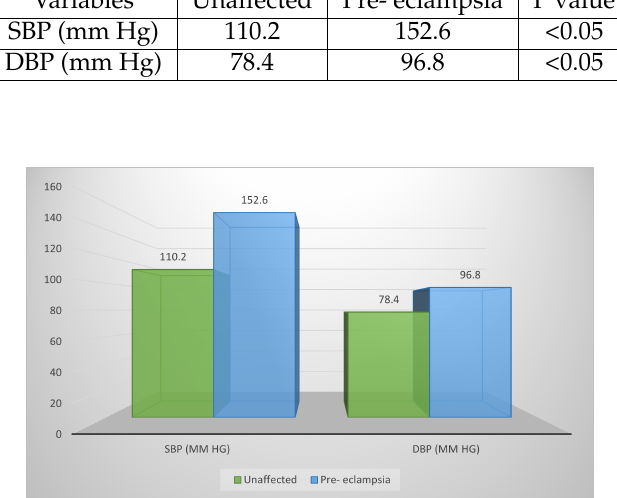
Figure 1. Graphic representation of the effect of ICT Solutions on total anthropogepainic GHG supply